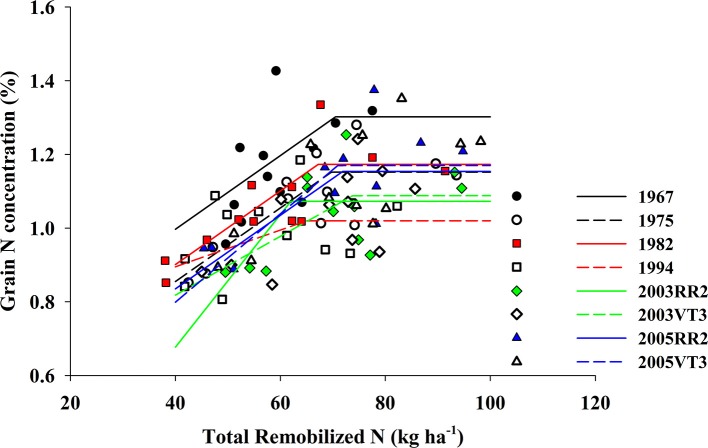
Bilinear model fitted for grain N concentration (%) and total remobilized N (kg ha−1) for eight hybrids. Slopes for eight hybrids are (order from 1967 to 2005VT3): 0.010, 0.010, 0.010, 0.005, 0.018, 0.008, 0.010, and 0.012. The threshold (x0) for eight hybrids are (order from 1967 to 2005VT3): 70, 70, 67, 65, 62, 74, 72, and 71 kg ha−1. The plateau for eight hybrids are (order from 1967 to 2005VT3): 1.30, 1.15, 1.17, 1.02, 1.07, 1.09, 1.15 and 1.17. And the R2 for fitted models are (order from 1967 to 2005VT3): 0.34, 0.65, 0.68, 0.19, 0.49, 0.45, 0.50 and 0.49. P-value for all fitted model are less than 0.05.